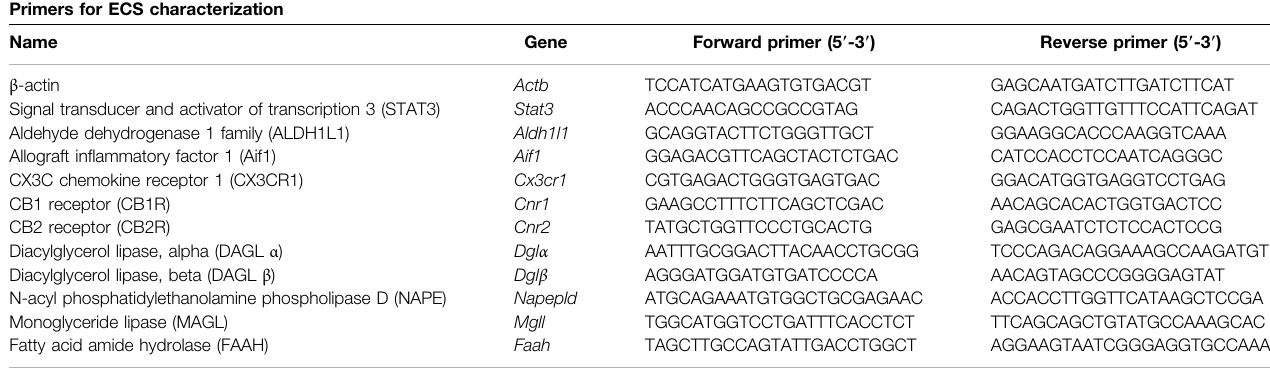
TABLE 2 | Primers used for qRT-PCR